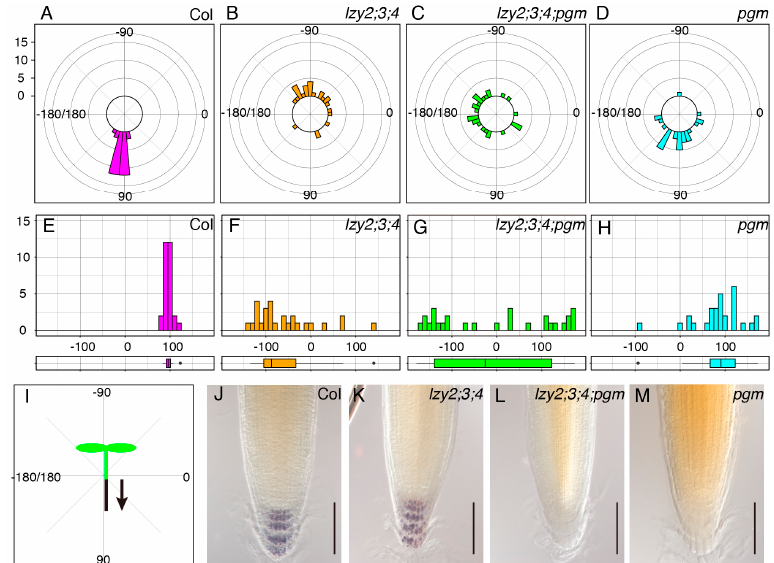
Figure 1. Genetic analysis of growth direction of primary roots. Polar distribution of growth direction of primary root in wild-type Col ( A ), lzy2;3;4 ( B ), lzy2;3;4;pgm ( C ), and pgm ( D ). Growth angles were plotted on histograms and distributions were evaluated with boxplots from wild-type Col ( E ), lzy2;3;4 ( F ), lzy2;3;4;pgm ( G ), and pgm ( H ). Schematic representation of growth angle quantification ( I ). Each bar indicates the number of roots. Lugoal’s staining of primary roots of wild-type Col ( J ), lzy2;3;4 ( K ), lzy2;3;4;pgm ( L ), and pgm ( M ) at 7 days after transferring to phytocabinet. Bars indicate 100 µ